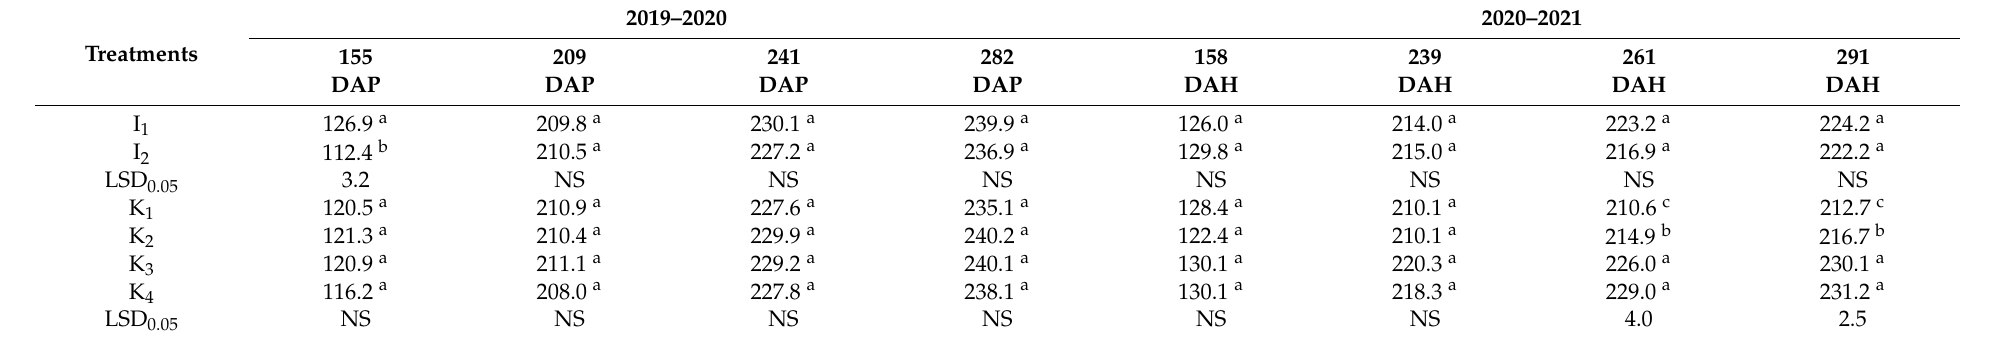
Table 5. Cane height (cm) as a function of irrigation and potash levels.